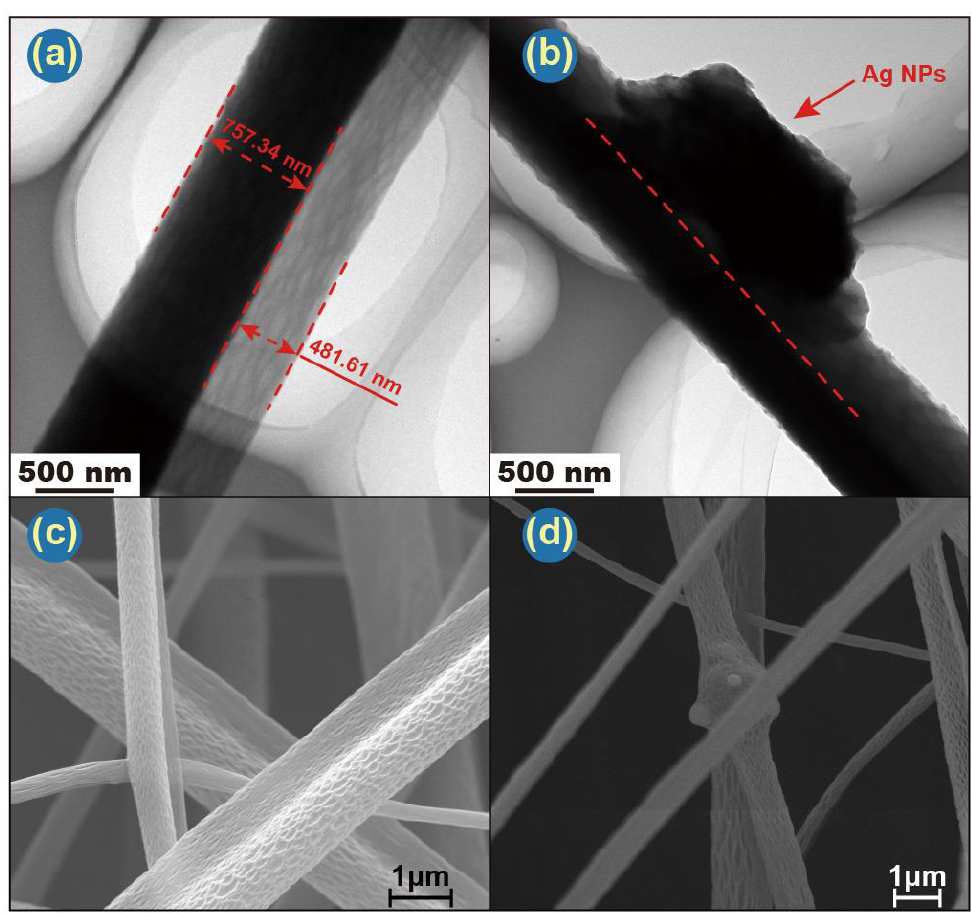
Figure 4. TEM images of ( a ) F1 and ( b ) F4. Scale bars are 500 nm. Enlarged SEM images of ( c ) F2 and ( d ) F3. Scale bars are 1 μm.